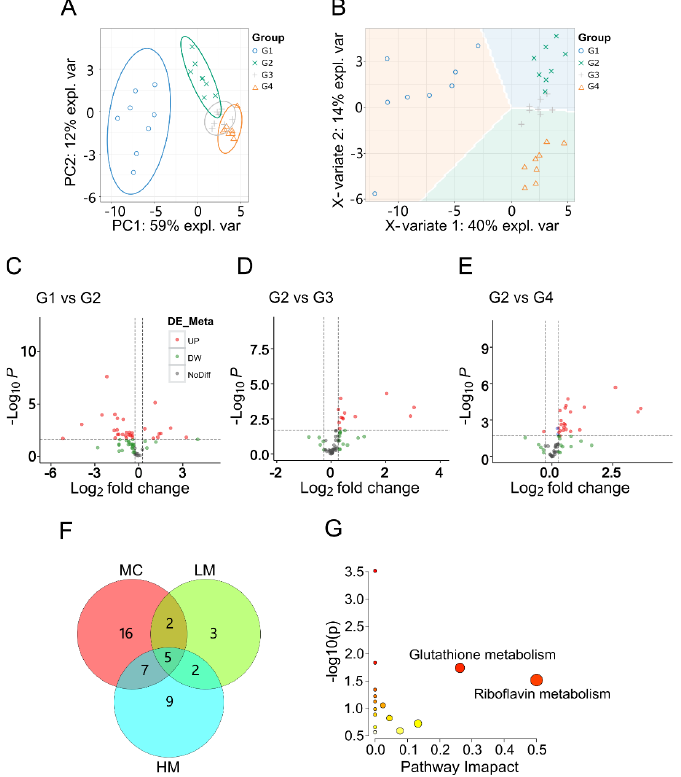
Figure 3. Metabolomic analysis of GRb1 treatment in diabetes zebrafish model. ( A , B ) Overall metabolic profiles of samples between control, model and test groups using PCA and PLS-DA plots. n = 8 per group. ( C – E ) Volcano plots of differential metabolites between G1 and G2, G2 and G3, and G2 and G4. G1, larvae exposed in E3 water; G2, larvae treated with 4% glucose; G3, larvae treated with 4% glucose + 100 μg/mL GRb1; G4, larvae treated with 4% glucose + 200 μg/mL GRb1. ( F ) Venn diagram of differential metabolite amounts. MC represents G2 vs. G1; LM represents G3 vs. G2; HM represents G4 vs. G2. ( G ) KEGG pathway maps for the differential metabolites.